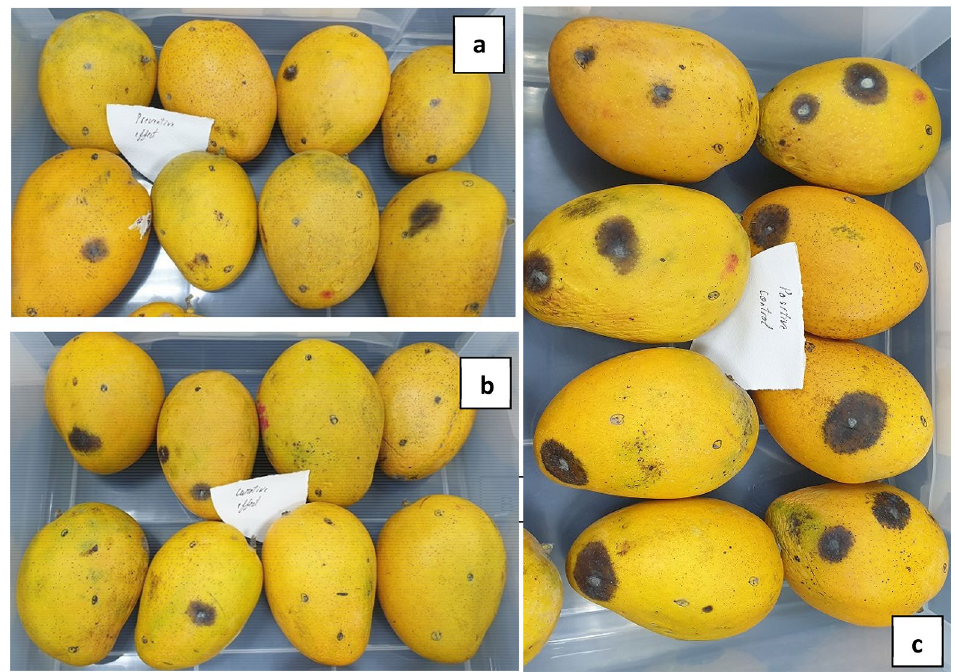
Figure 4. Disease incidence in mango samples inoculated with A. alternata . All samples are 10 days old after treatment at 25 °C. ( a ) Preventive effect of PJ-WS-LE extract. ( b ) Curative effect of PJ-WS-LE extract. ( c ) Control samples inoculated with A. alternata and not treated with PJ-WS-LE extracts.